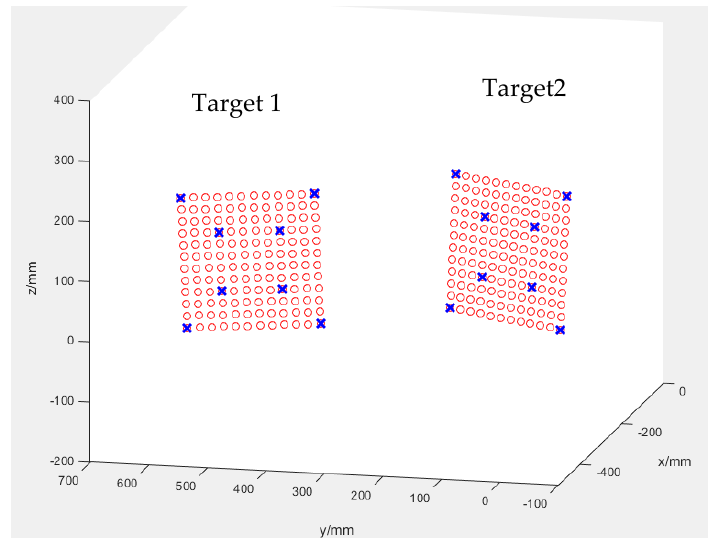
Figure 8. The spatial coordinates of the measured points on target 3 and target 4. The red circle represents the corner point of the targets, and the blue crosses represent the measured points. Table 4. Coordinate values of measuring